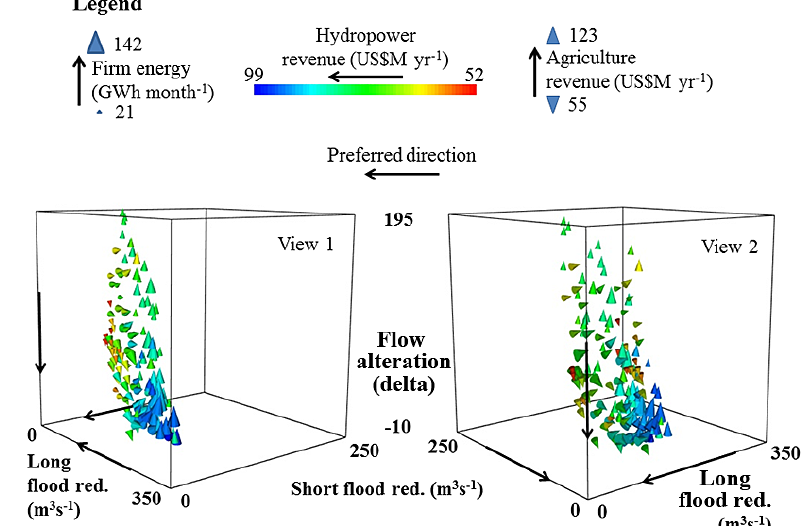
Figure 5. The same trade-off surface as Fig. 4a with cones replacing spheres. Their orientation shows agriculture revenue from lowest (pointing down) to highest (pointing up). Agriculture revenues trade-off against flood peak objectives and correlate with firm energy, except at the highest agricultural revenues, where there is a